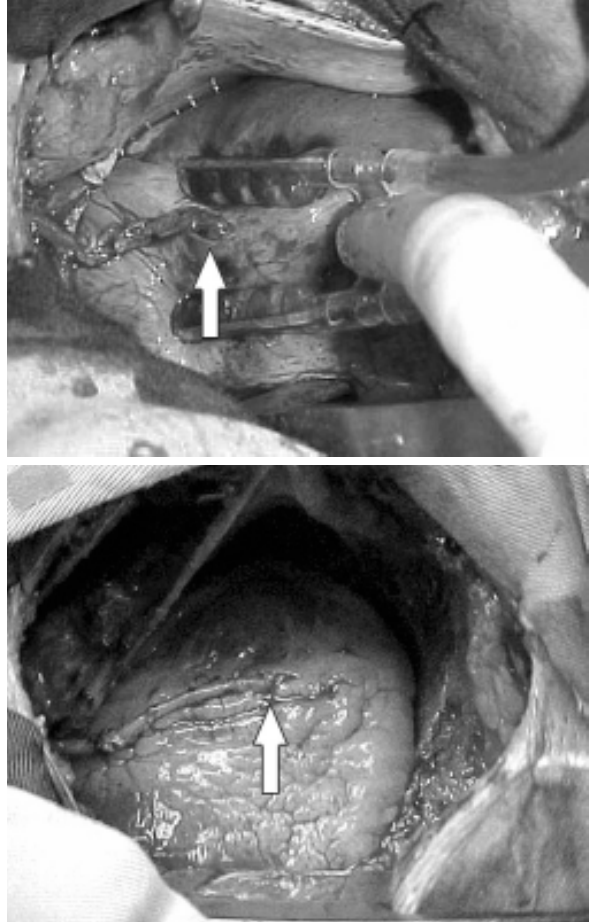
Fig. 2 - Aspectos da anastomose do enxerto de artéria torácica interna esquerda com a artéria descendente anterior (indicado pela seta)